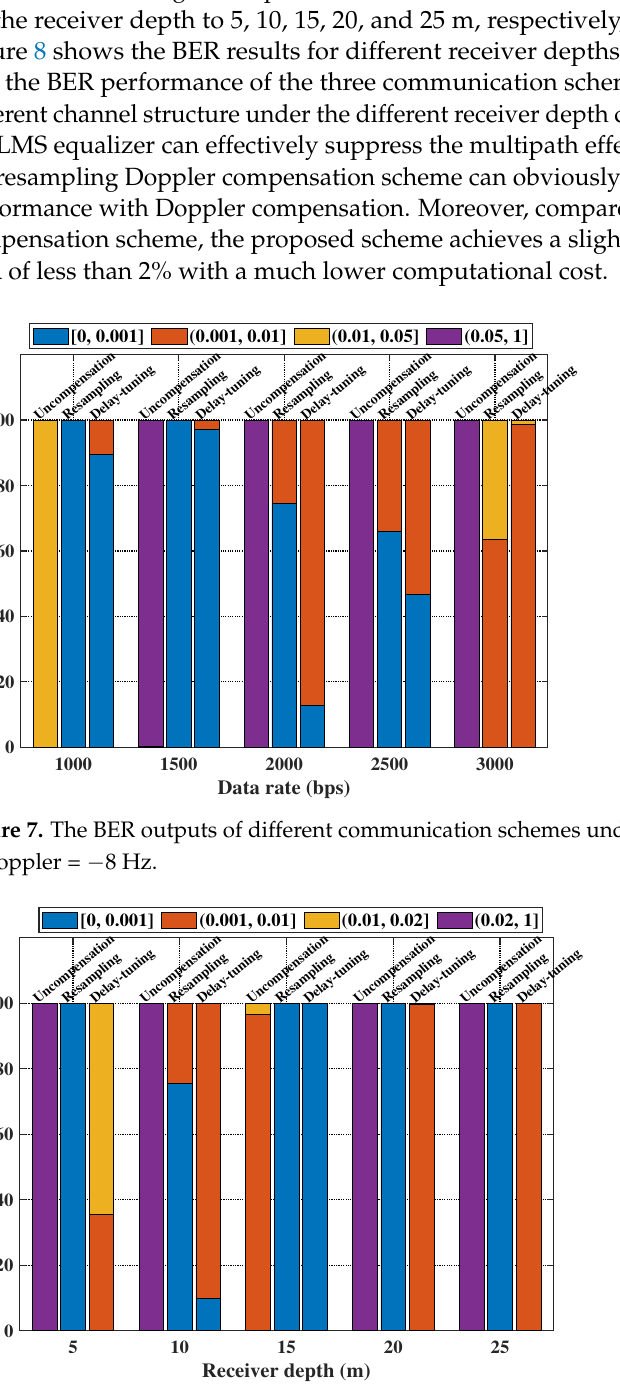
Figure 8. The BER outputs of different communication schemes under different receiver depth conditions at Doppler = − 8